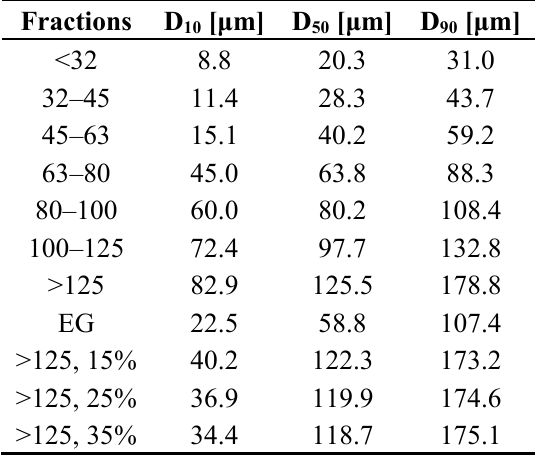
Table 3. Results from analysis of particle size distribution (PSD).